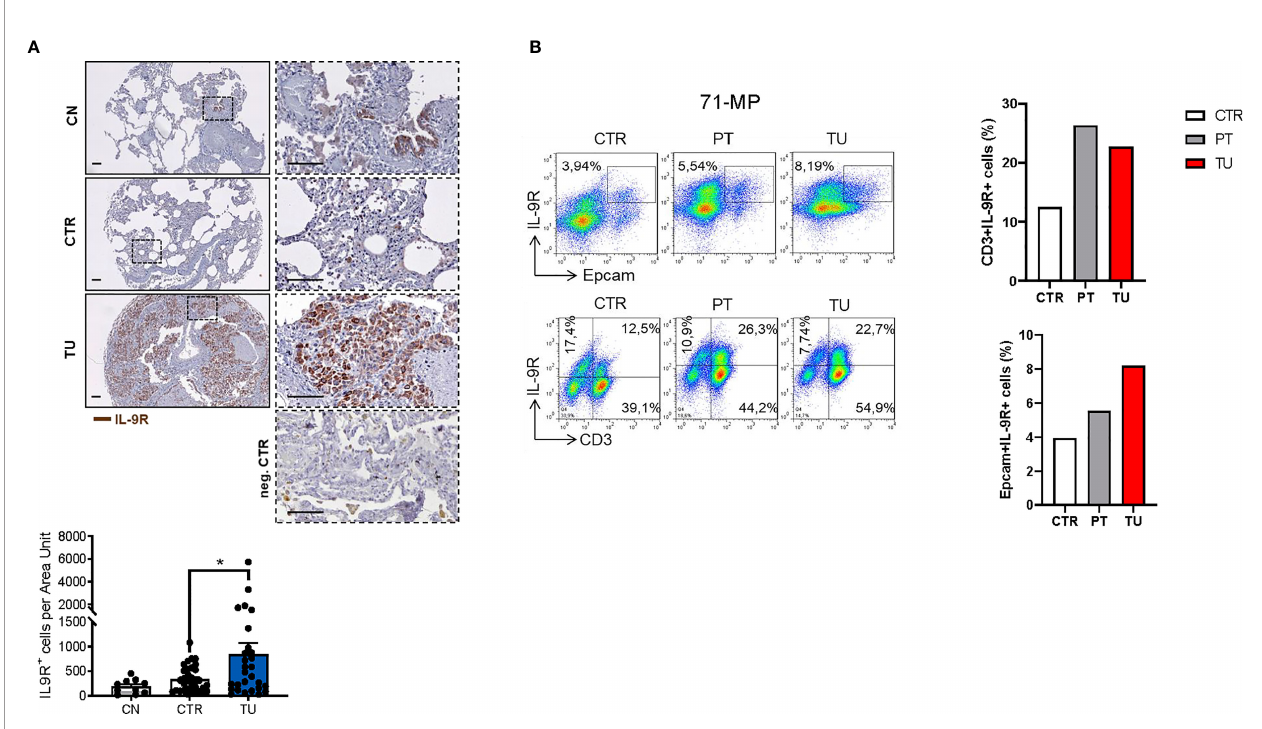
FIGURE 3 | Increased IL-9 Receptor expression in the lung of NSCLC patients. (A) Immunohistochemistry staining of lung tissue sections for IL-9R (colored in brown). Representative microscopy images are shown for one healthy control patient (CN), the CTR and TU from one NSCLC patient and a negative Control. Images were taken at a 20x magni fi cation while squared areas are shown below at a magni fi cation of 60x. Quanti fi cation of the data is shown below as mean ± SEM using ordinary one-way ANOVA (nCN=10, nCTR=33, nTU=28), *P,0.05; **P,0.01; ***P,0.001. (B) Flow cytometry analysis of IL-9R + cells (%) in association with Epcam + and CD3 + lung tissue cells derived from the CTR, the PT and the TU from a representative patient with NSCLC (patient ID: 71-MP). Percentage of CD3+IL-9R+ and EpCAM+IL-9R+ cells is shown in the